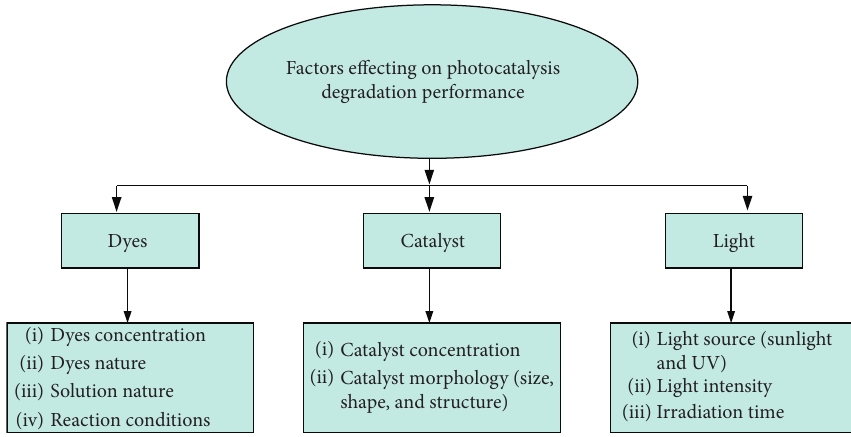
Figure 4: Factors’ effect on photocatalysis processes of ZnO